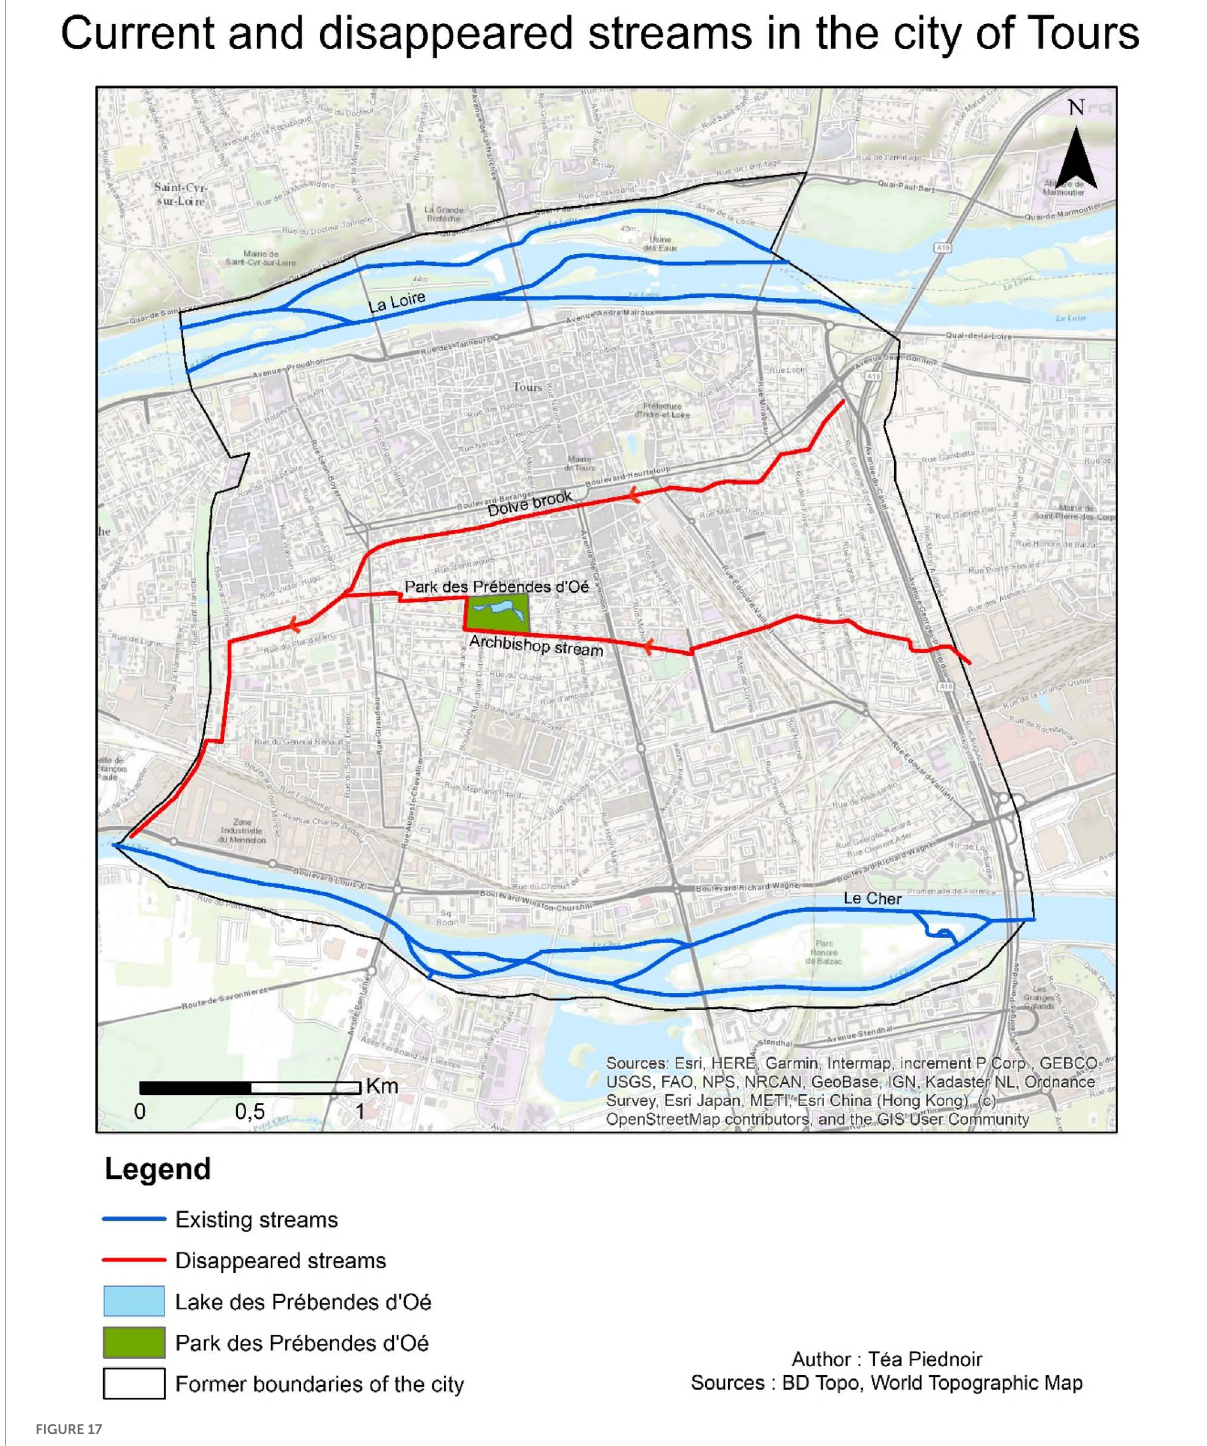
FIGURE17 Map showing the current and buried streams in center Tours.